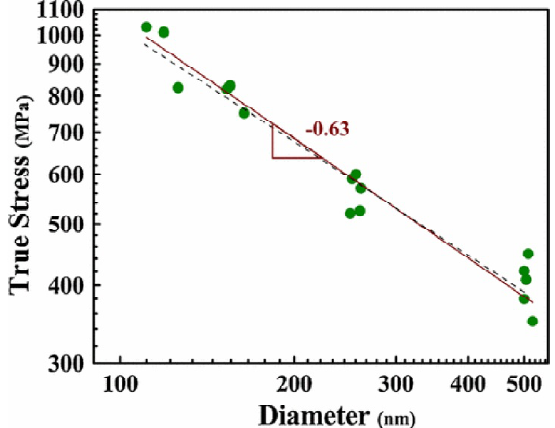
Fig. 10. Flow stress at 10% strain for Cu nanopillars fabricated by electroplating, presenting a power-law trend with n=”0.63, nearly identical to the trend dem- onstrated in FCC metals represented by the solid line. Reprinted with permission from Jennings AT, Burek MJ, Greer JR. 2010. Microstructure versus Size: Mechanical Properties of Electroplated Sin- gle Crystalline Cu Nanopillars. Physical Review